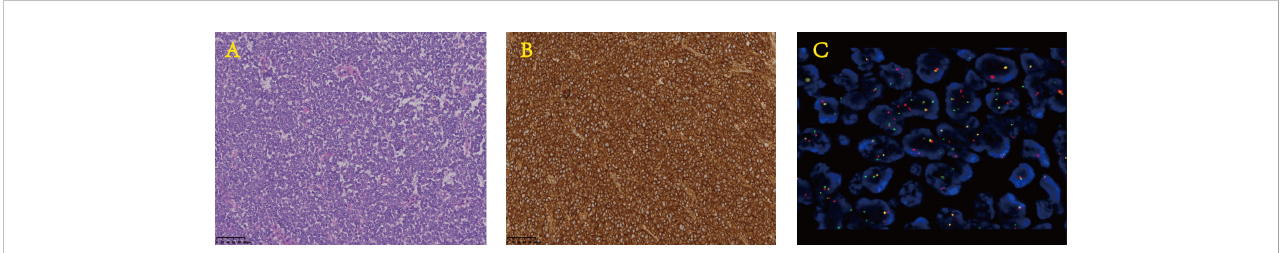
FIGURE 2 Pathological image of surgical specimens. (A) H&E. (B) CD99. (C) Detection of EWSR1 gene disruption by FISH. The probe type: Vysis LSI EWSR1 Probe (LOT 455960). Result of the patient ’ s EWSR1 gene disruption test: positive (count 200 cells, approximately 90% show separation signal). FISH, fl uorescence in situ